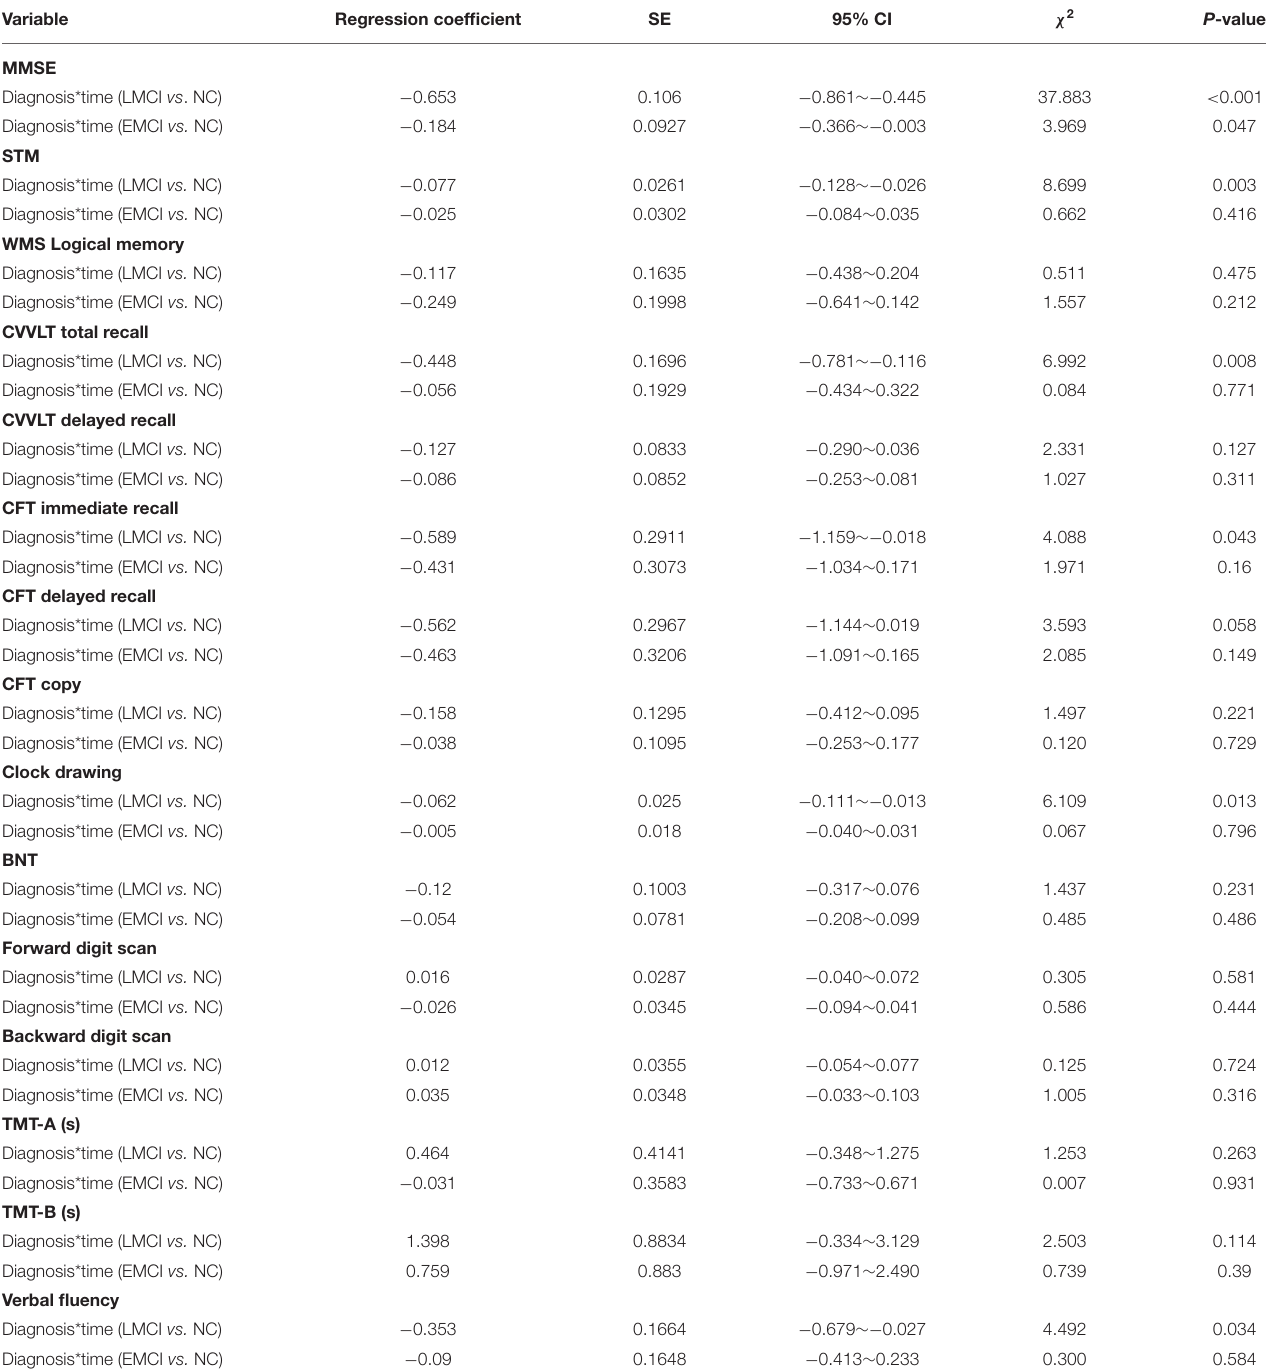
TABLE 3 | Generalized Estimating Equations (GEE) analysis of the annual change in each neuropsychological